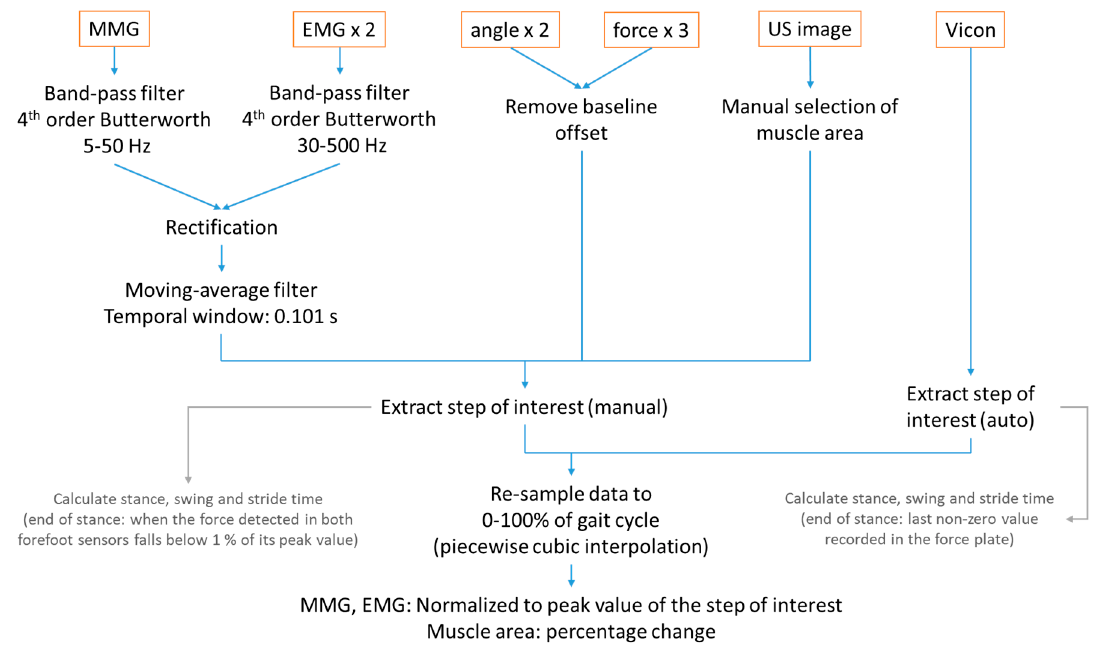
Figure 2. Flow chart for data processing and analysis.